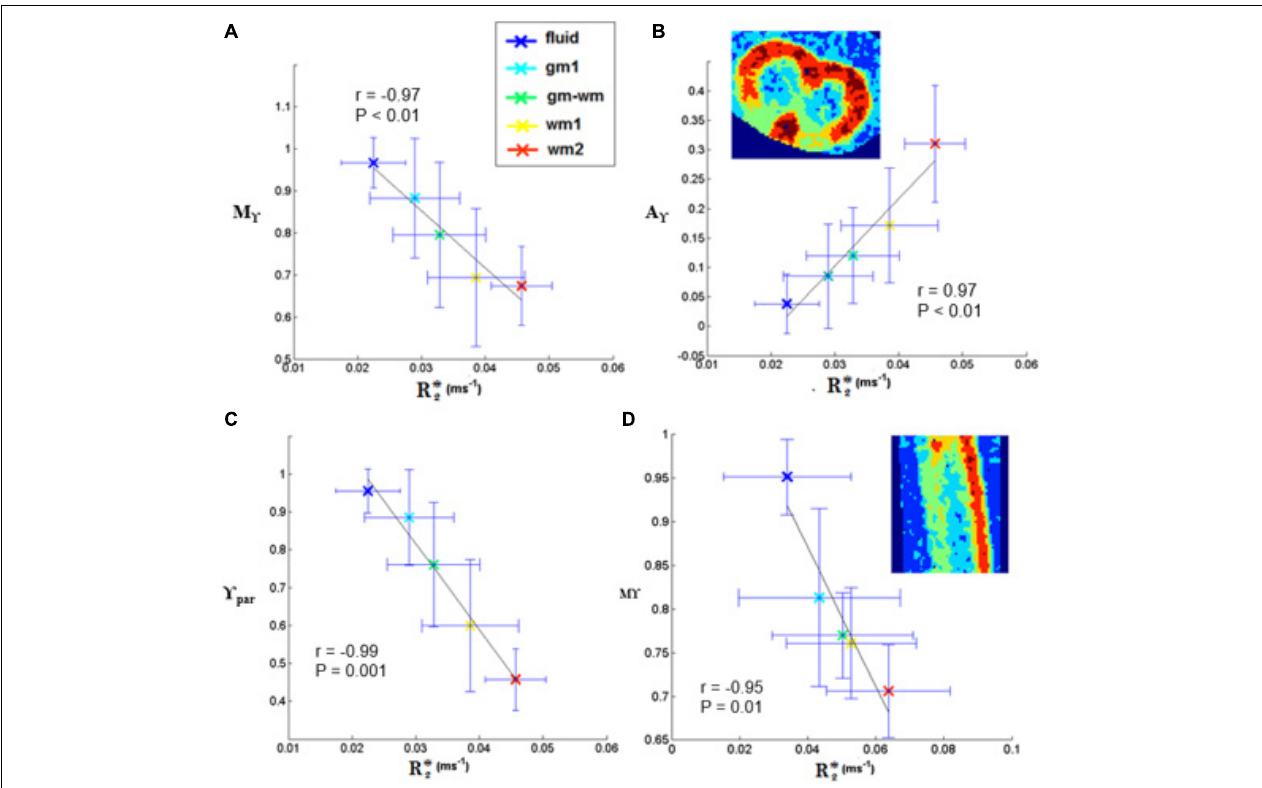
FIGURE 9 | Plots of γ -imaging metrics as a function of R2*. Mean- γ (M γ ), γ -anisotropy (A γ ) and longitudinal γ ( γ par ) plotted as a function of R2* in axial (A-C) and in sagittal slices (D) . The tissue was divided in different regions by applying thresholds on the mean-diffusivity map. The distinct regions are listed in the legend and comprise: the medium surrounding the spinal cord (fluid), two ROIs in the white matter (wm1, wm2), one in the gray matter (gm1), and one at the interface (gm-wm). The Pearson’s correlation coefficient is indicated in the box, together with the level of significance, P. The black line represents the linear fit. TABLE 3 | Linear correlations between DTI, QSI, tAD diffusion metrics and histology. Axon Diameter Diameter SD Axon Density Effective local density